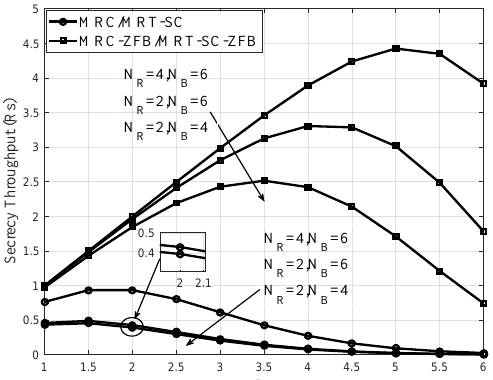
Figure 8. Throughput of the two schemes vs different with SNR = 20 dB, Q = 20 dB, and different values N R and N B